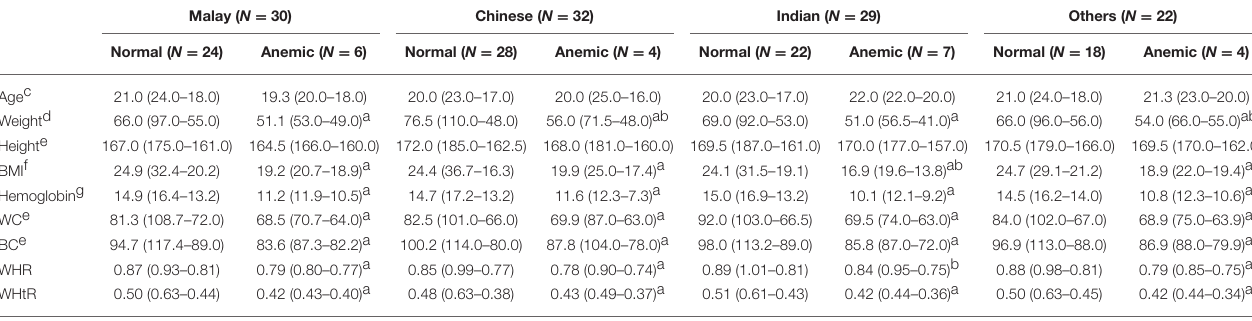
TABLE 5 | Comparison of various parameters among the men of different ethnic